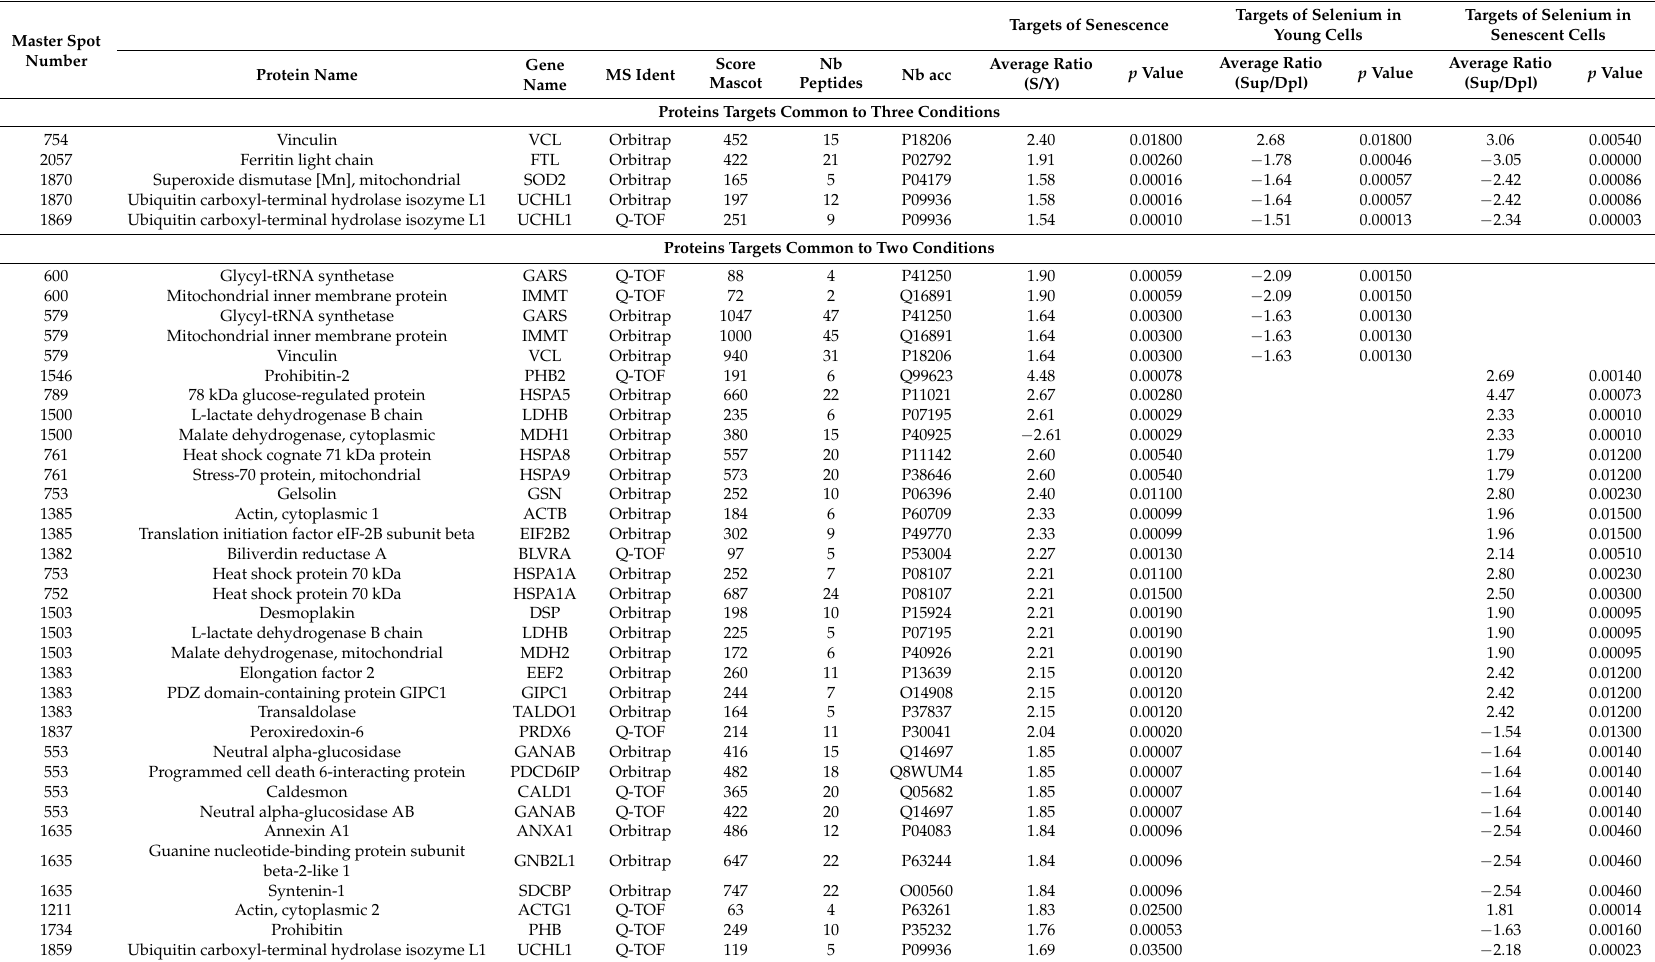
Table 1. List of proteins identified by tandem mass spectrometry (MS/MS) (either by quadrupole-time-of-flight (Q-TOF) or Orbitrap) from the coomassie blue-stained gel (presented in Figure